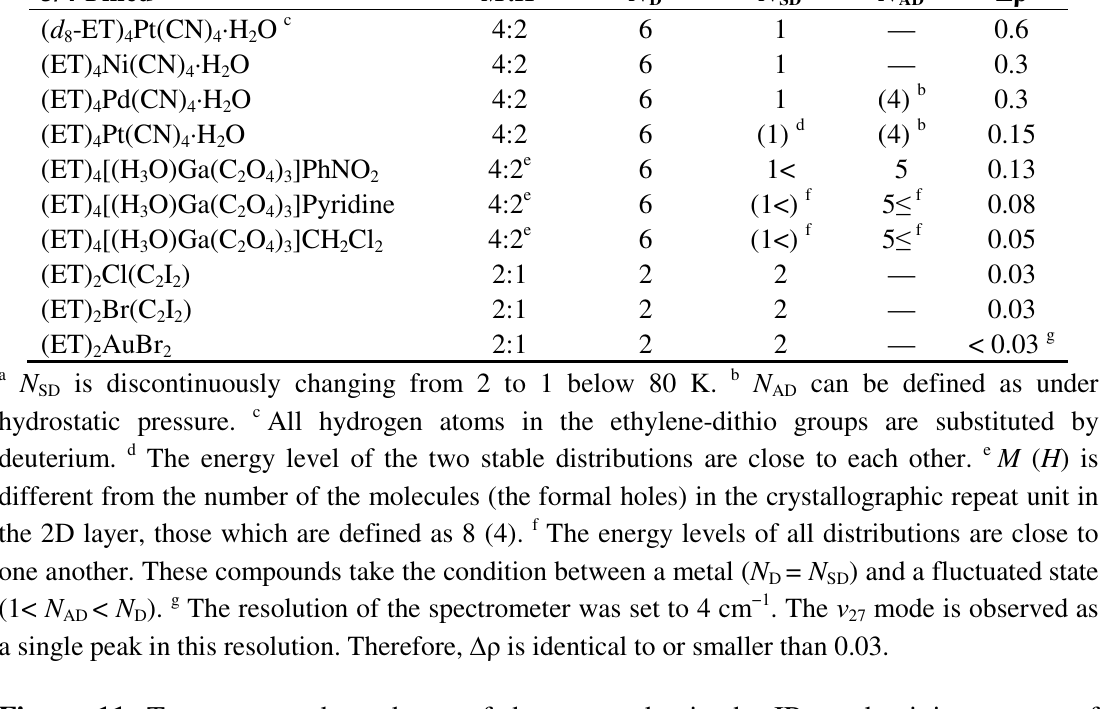
Figure 11. Temperature dependence of the β ″ -(ET) (ReO ) . The spectra are obtained after Kramers 3 4 2 transformation of the IR-reflectance spectra. The is parallel to the inter-layer direction. The broken lines are a guide for the eyes. Offsets are layer direction. The broken lines are a guide for the eyes. Offsets applied to all the spectra, except for the spectra at 300 K.